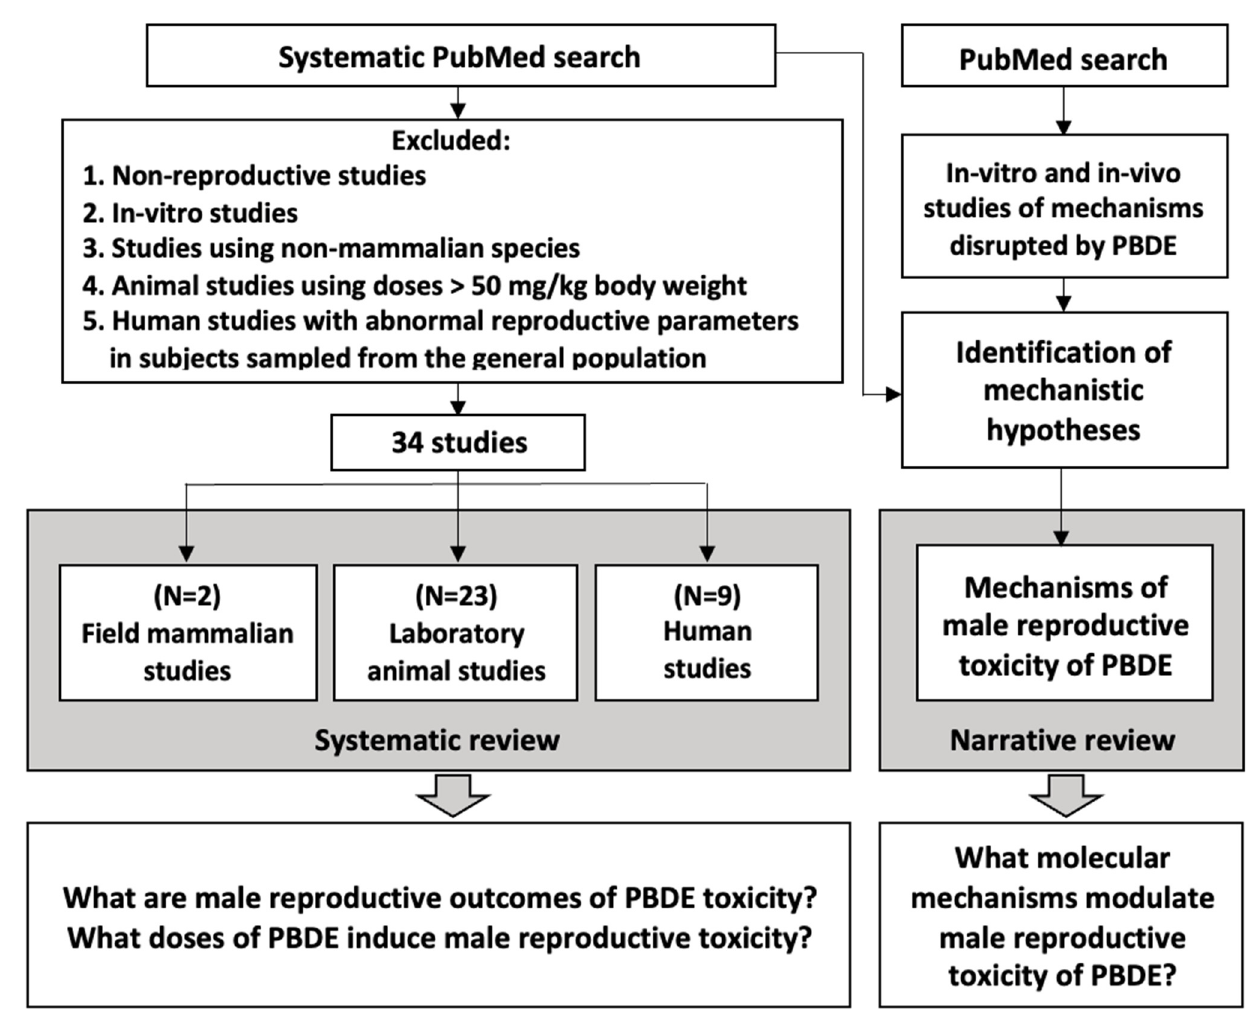
Figure 2. Literature flow diagram for disruption of male reproduction by PBDEs.